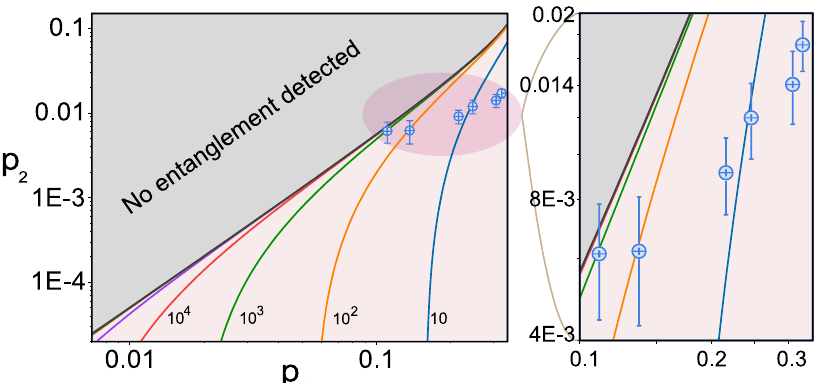
Fig. 2 Dynamical evolution of the multipartite entanglement. The veri fi cation results of witness and dynamical evolution of M values with different storage times in 30, 120, 300, 450, 900, and 1200 ns from right to left. The corresponding different M values of theoretical lower bound curves of witness are 10 – 10 6 from right to left. The M values for experimental data are 5, 6, 10, 14, 92, and 1000 in the right subgraph. According to the error bars from the statistical data, we can deliver the upper bound of the M values as 5 ; 6 ; 12 ; 16 ; 130 ; þ1½ (cid:5) , and the lower bound as 5 ; 5 ; 9 ; 13 ; 90 ; 323 ½ (cid:5) . Here, the + ∞ of M values represents the approach to the classical bound. Error bars are derived by the Poisson distribution of photon number statistics from avalanche